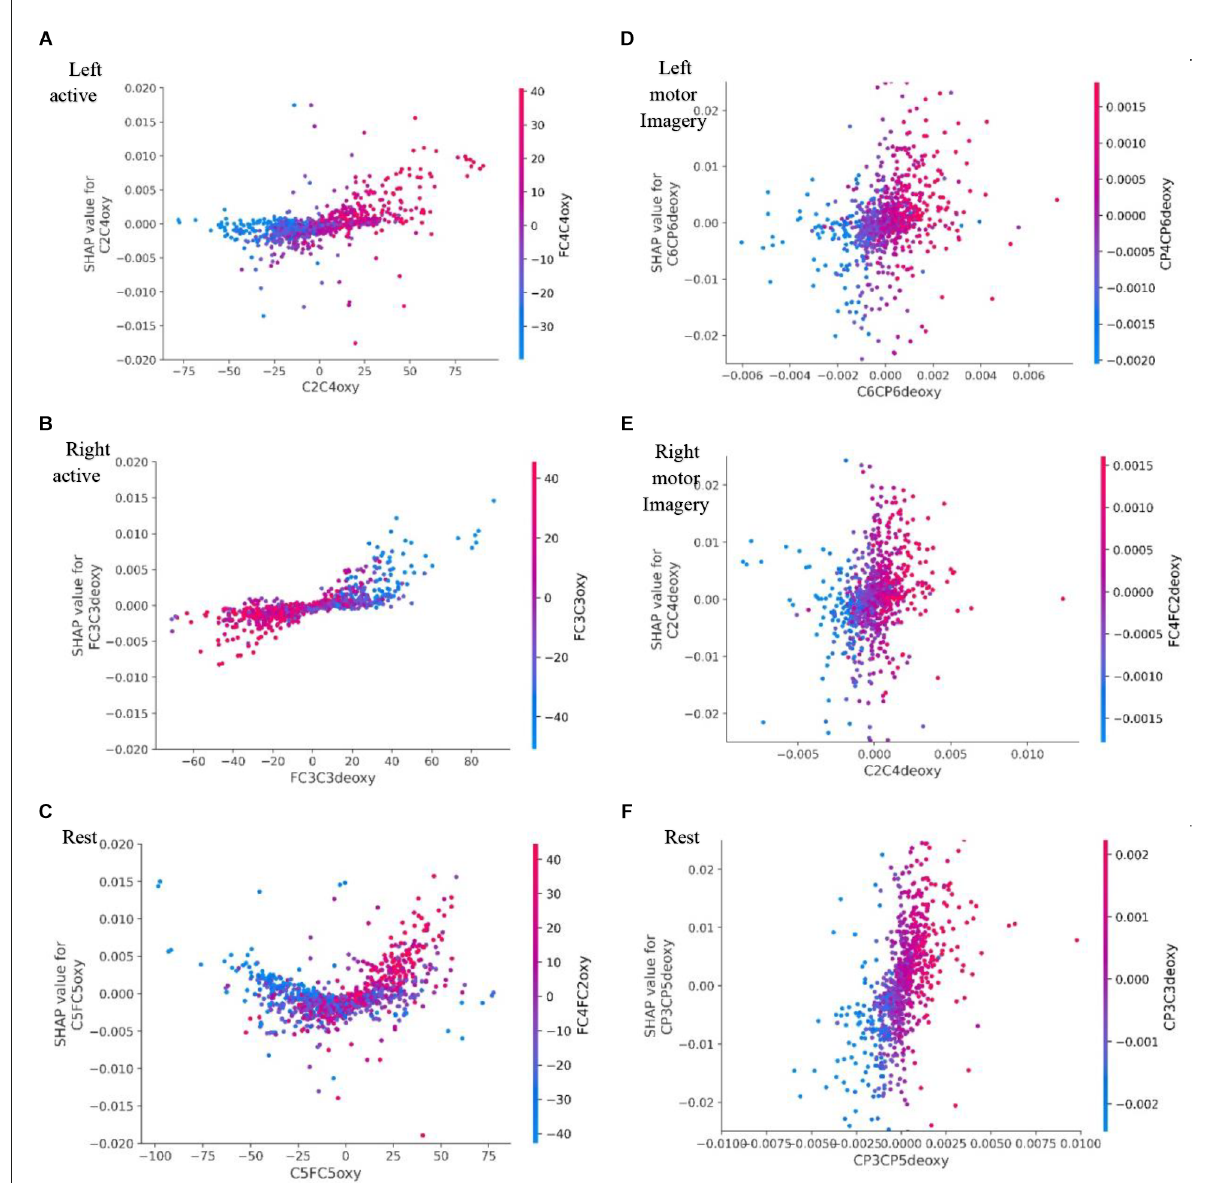
FIGURE17 Dataset A’s SHAP dependance plot for: (A) represents Left active motor task; (B) represents Right active motor task and likewise (C) represents Rest. Dataset B’s SHAP dependance plot for: (D) represents Left motor imagery; (E) represents Right motor imagery and likewise (F) represents Rest. Here the SHAP dependence plot where the SHAP value of the feature has a positive effect on the classification is plotted against the value of the feature for all examples over the dataset and it is color coded with the feature it interacts with the most. SHAP, SHapley Additive exPlanations.